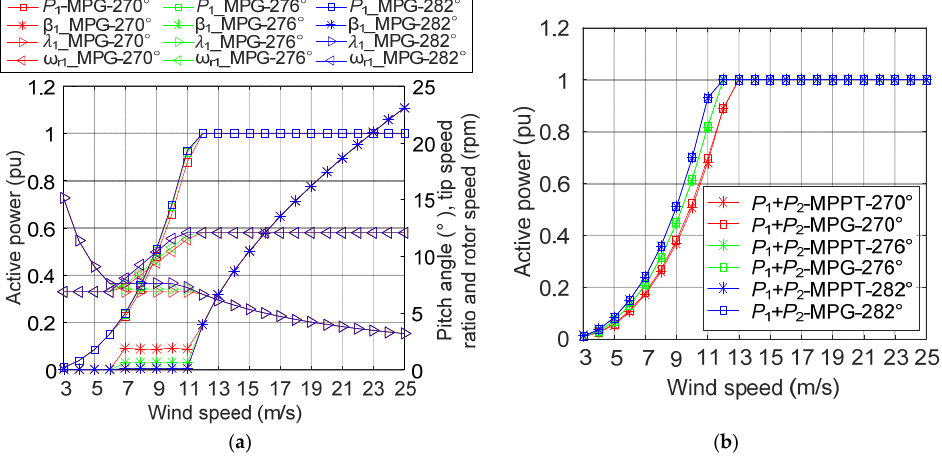
Figure 10. Active power generation of WT 1 and the whole wind farm at various wind directions: ( a ) pitch angle, tip speed ratio, rotor speed, and active power of WT 1 ; ( b ) comparison of the total active power of the wind farm between the MPPT and the MPG control.